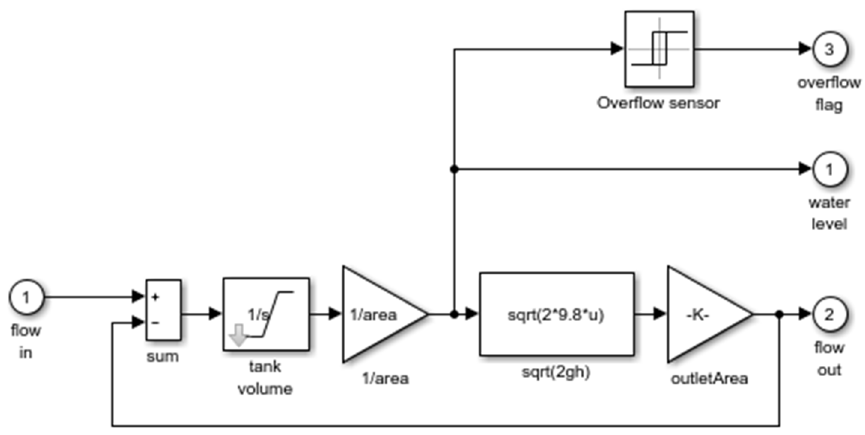
Figure 3. Tank model.